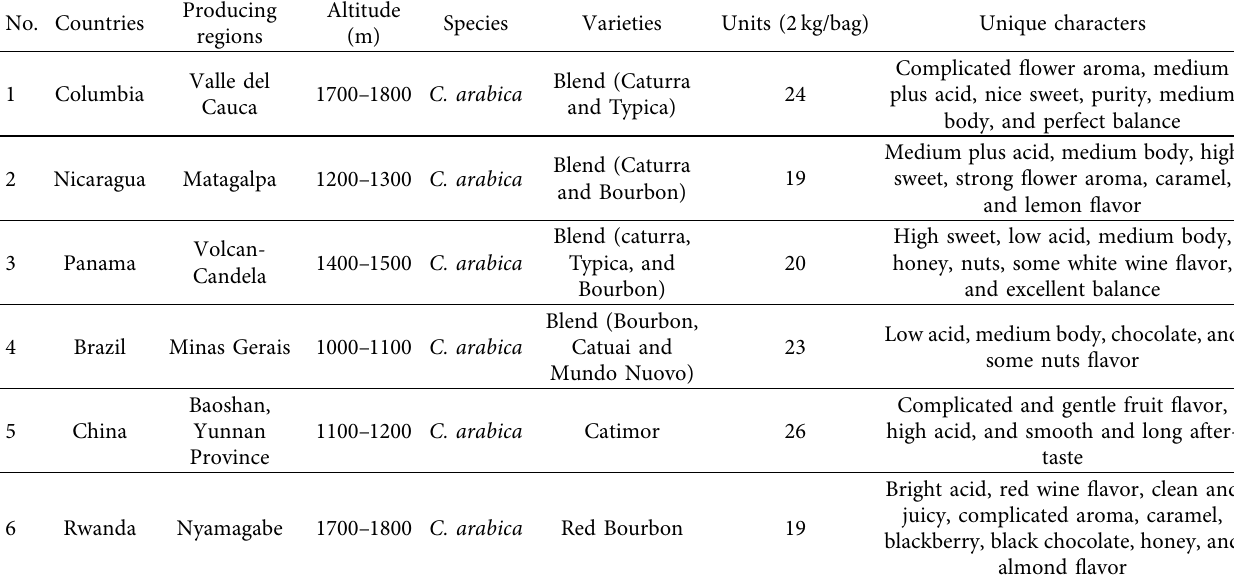
Table 1: Geographical origins of 131 cofee bean